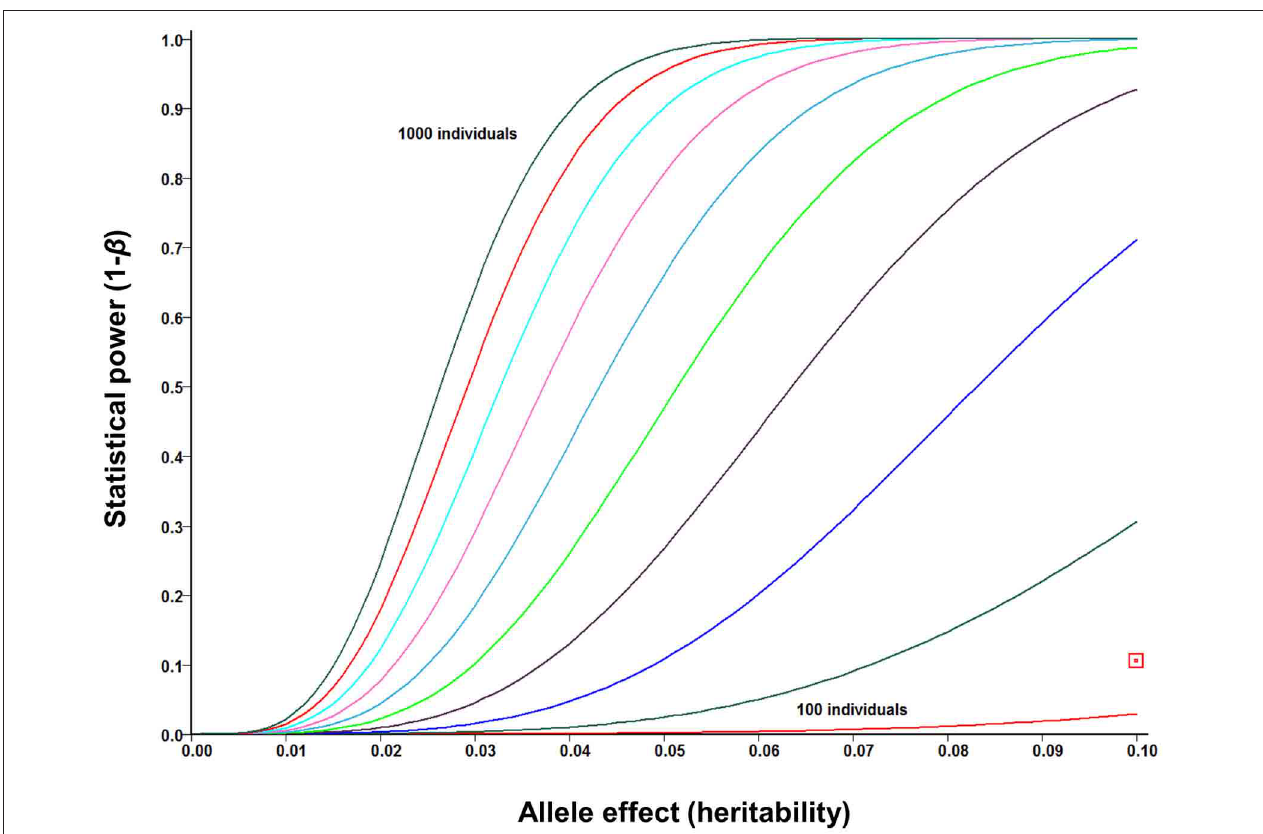
FIGURE 6 | Statistical power of genome-wide association studies (GWASs) under ideal circumstances (i.e., no confounding, causative polymorphisms genotyped directly) for mapping population sizes ranging from N = 100 to N = 1000 (in increments of N = 100) and allele